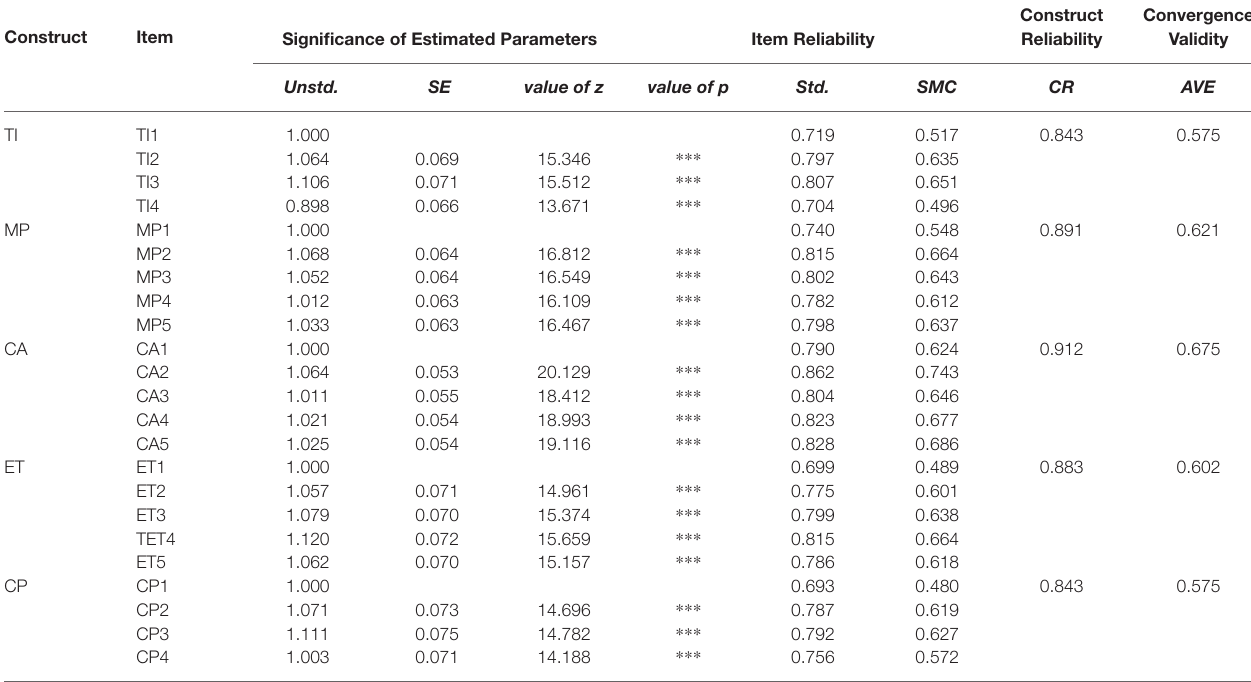
TABLE 2 | Confirmatory factor analysis.